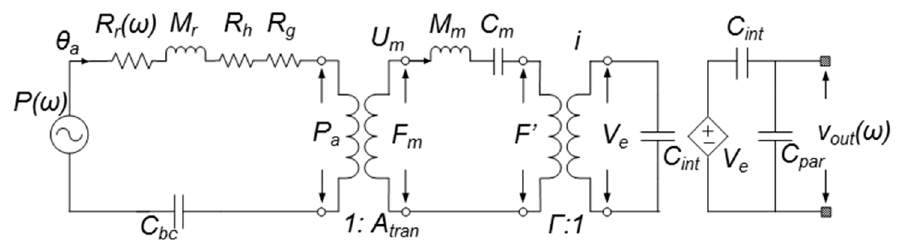
Figure 4. An equivalent circuit describing interaction between lumped parameters in the three-signal domain for a structure-based analogous model of open-circuit